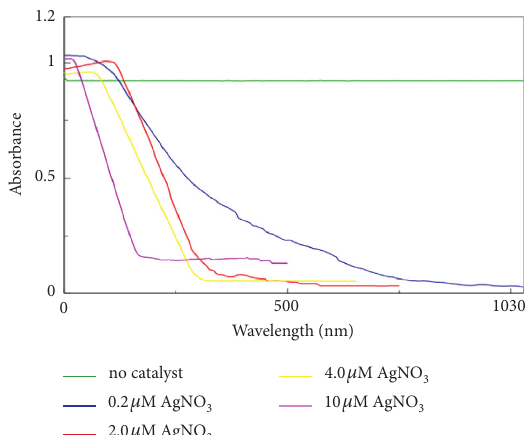
Figure 9: Time-dependent 400nm absorbance of 4-NP reduction with different silver content in the Ag/SiO